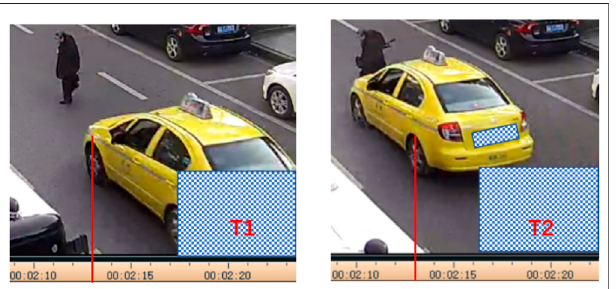
FIGURE 1 | Videos captured for estimation of vehicle impact speed and pedestrian posture.